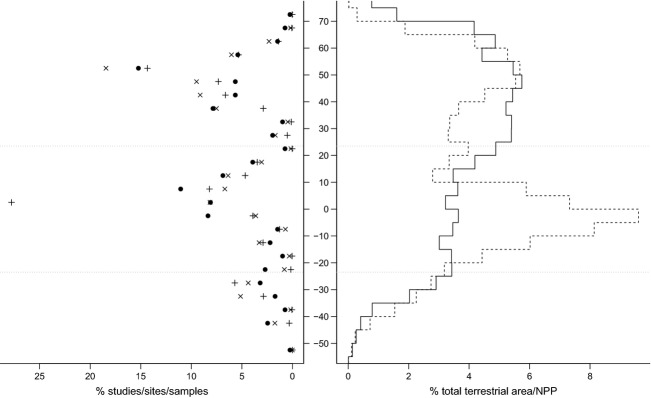
Latitudinal coverage. The percentage of Studies (circles), Sites (crosses) and samples (pluses) in five-degree bands of latitude. We computed each Study's latitude as the median of its Sites’ latitudes. The solid and dashed lines show the percentage of total terrestrial area and percentage of total terrestrial NPP, respectively, in each five-degree band (see “ Biogeographical coverage ” in Methods). The dotted horizontal lines indicate the extent of the tropics.